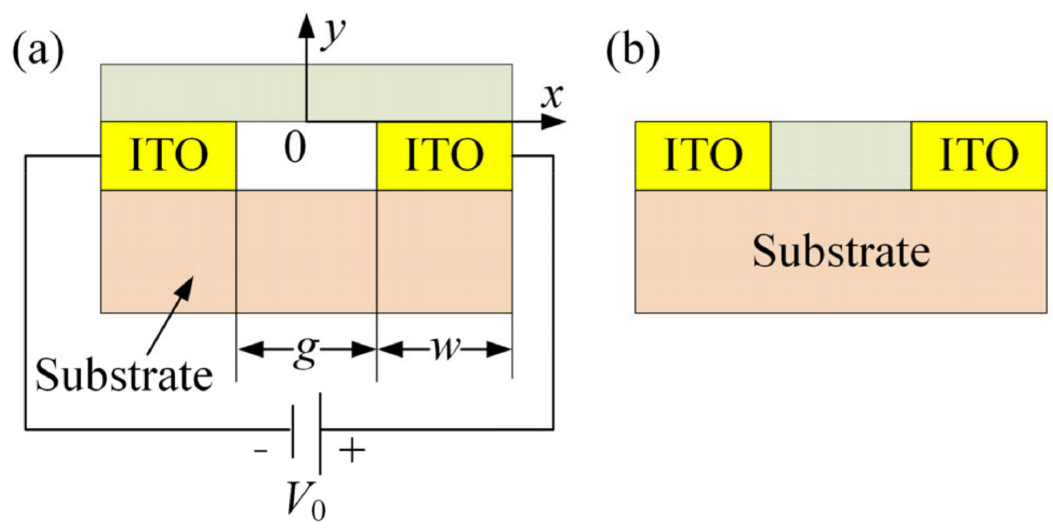
Figure 1. A cross-section view of the x − y plane with a pair of IDE placed ( a ) at the bottom with an applied voltage of V 0 and ( b ) at the side of the sensitive